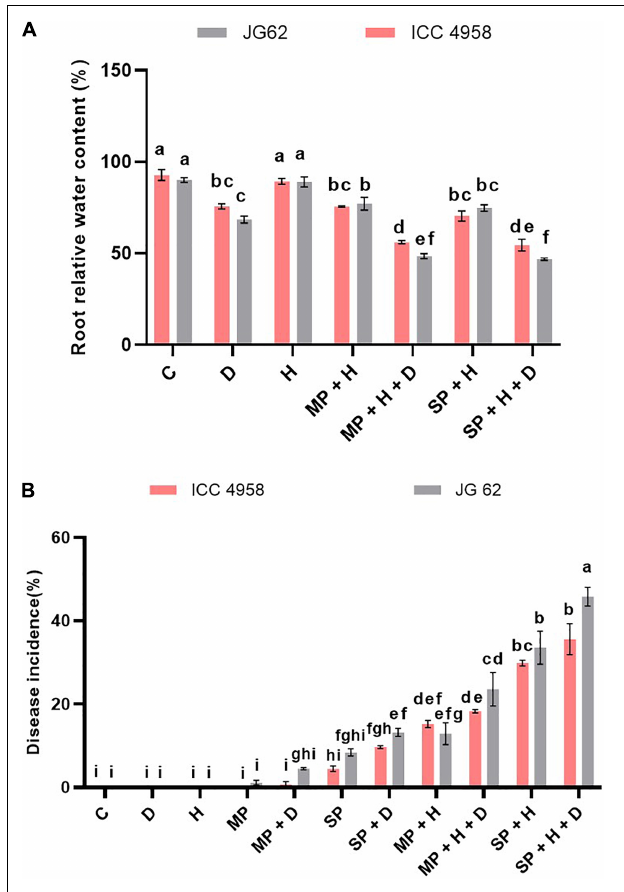
FIGURE 4 | Combined drought and heat stress significantly alter the DRR disease development in chickpeas. Chickpea plants were exposed to different treatments namely, control, drought, heat, mild pathogen, mild pathogen + drought, severe pathogen, severe pathogen + drought,